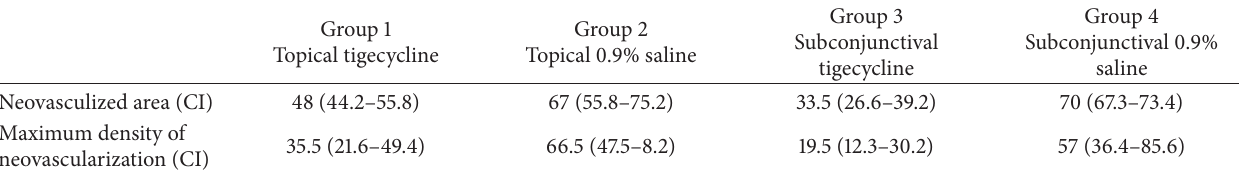
Figure 3: Histopathologic photographs of cornea after chemical burn. (a) Normal cornea. (b) An example of topically tigecycline-treated eyes revealing less corneal neovascularization. (c) Subconjunctivally tigecycline-treated eyes showing virtually few neovascularization than in control group in stroma. (d) Diffuse and intense neovascularization affecting deep stromal layers after in control eyes. Table 2: The median percentages of corneal neovascularization and maximum density of neovascularization (histopathological examination) in